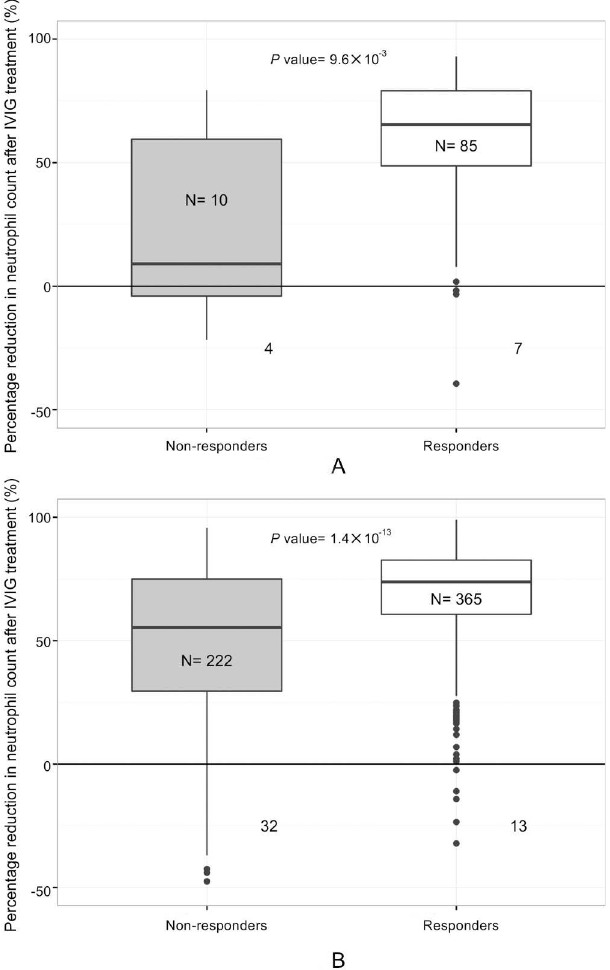
Fig 4. Neutrophil reduction in response to IVIG treatment in two independent cohorts. All P values were calculatedusing Wilcoxon rank sum test. A) Cohort III. B) Cohort IV. The number of patients with rising neutrophilcounts after IVIG treatment were indicatedby the numbersbelow x axis alongside each box plot. The P values were calculatedusing Wilcoxon rank sum test.